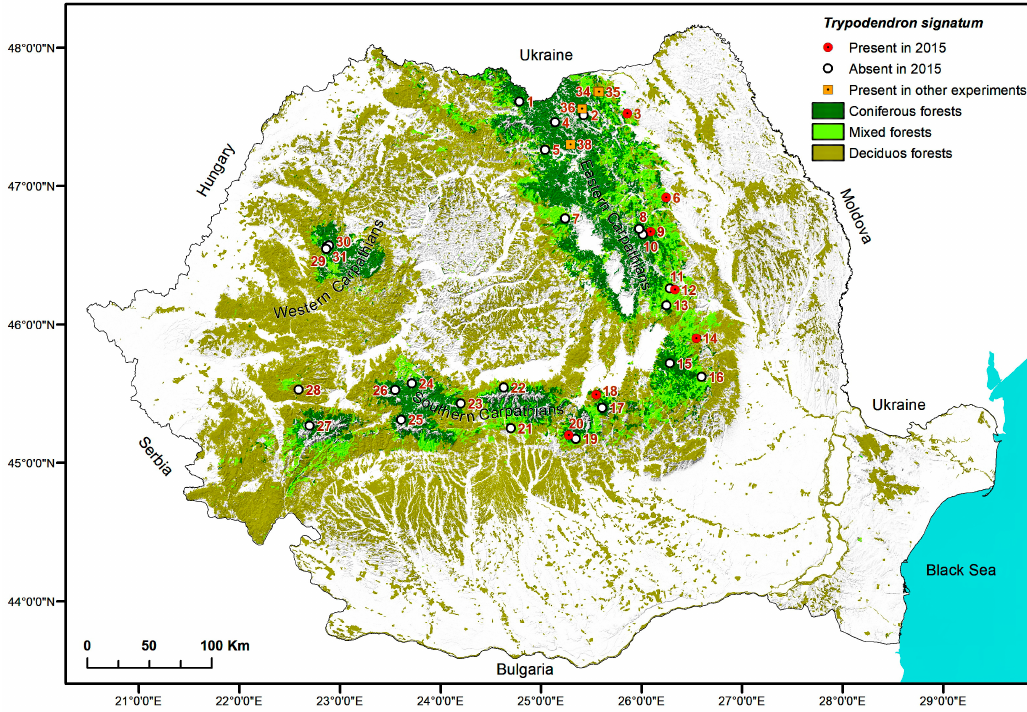
Figure 4. Sampling locations where Trypodendron signatum was found in 2015 or on other occasions mentioned in this study.